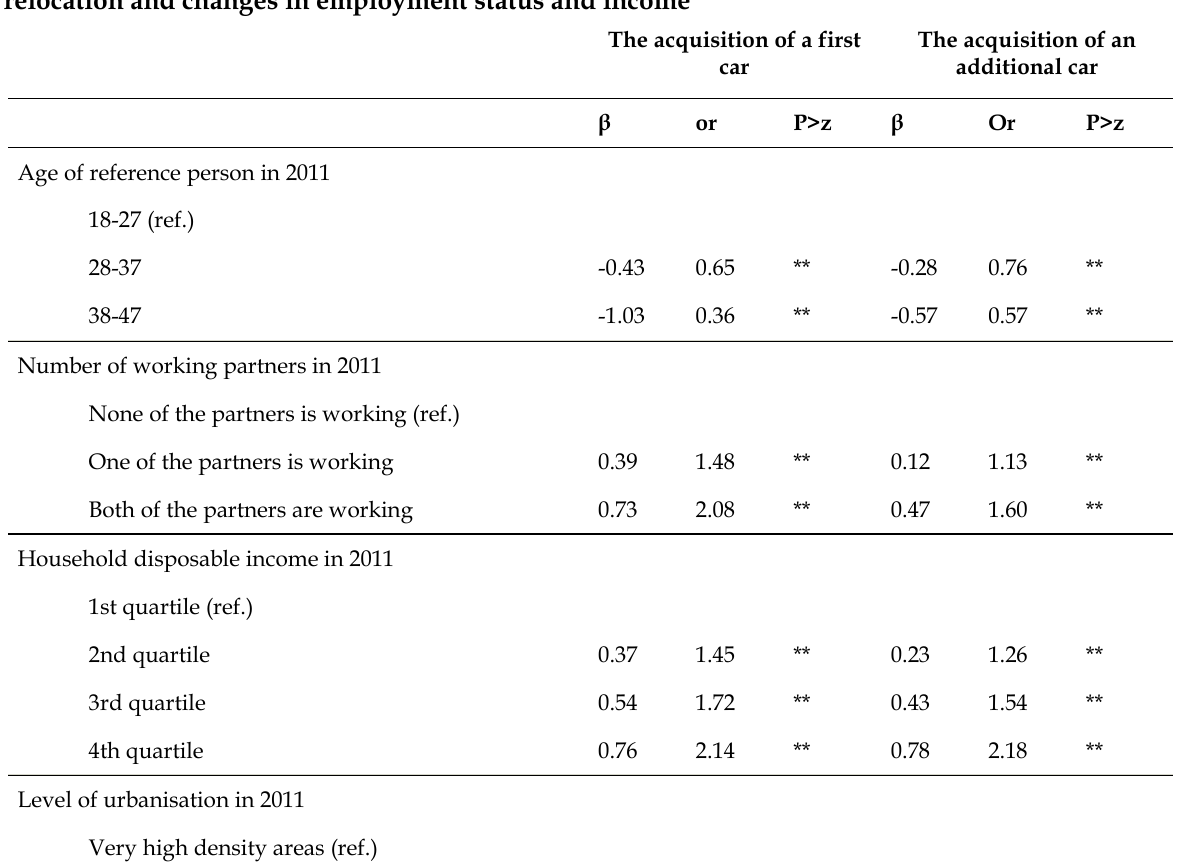
Table 2. Relationship between car acquisition and entry into parenthood, residential relocation and changes in employment status and